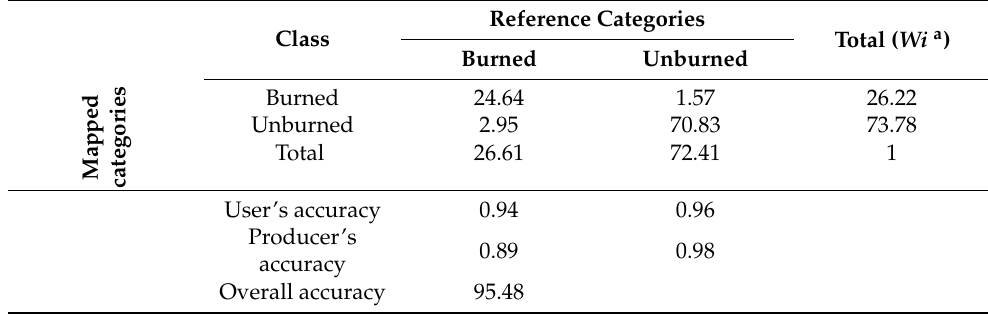
Table 3. Confusion matrix and accuracy